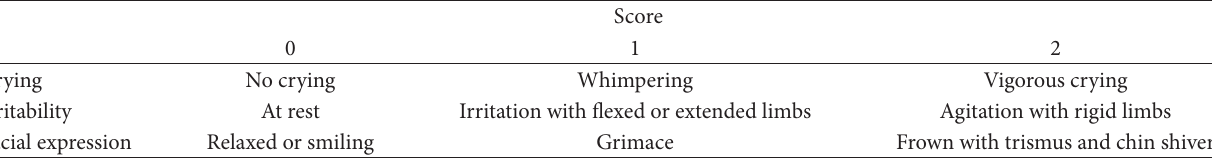
Table 1: Infant pain scale.